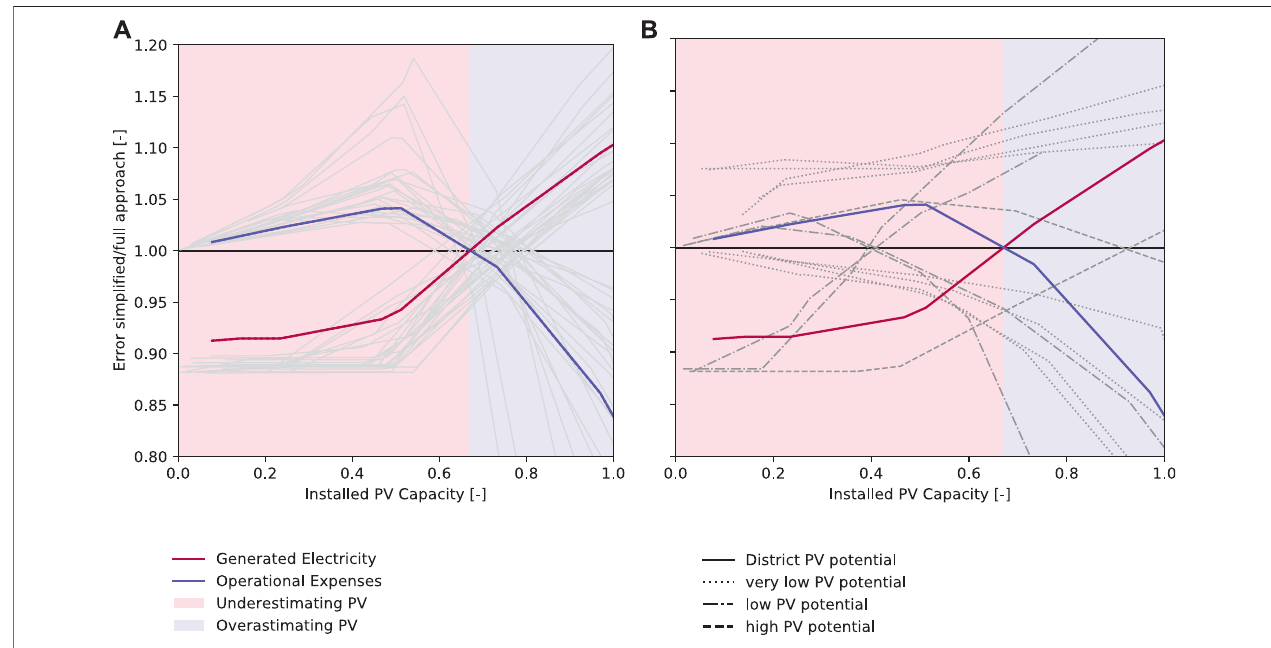
FIGURE 11 | Error caused by assuming horizontal PV panels to optimal PV orientation for a district (colored lines) of 40 buildings (gray lines); Buildings with (A) average behavior (B) outlier behavior.